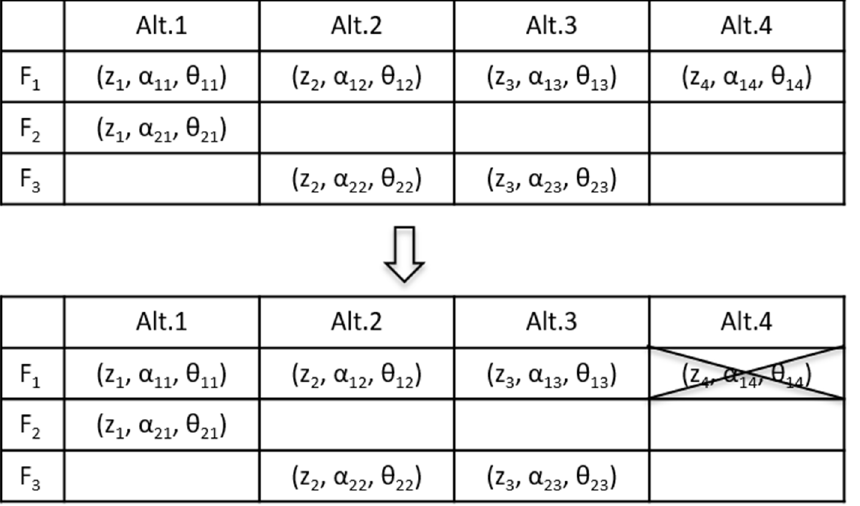
Figure 28. The matrices illustrates how the optimization criteria minimizes the number of Z M con- figuration alternatives.